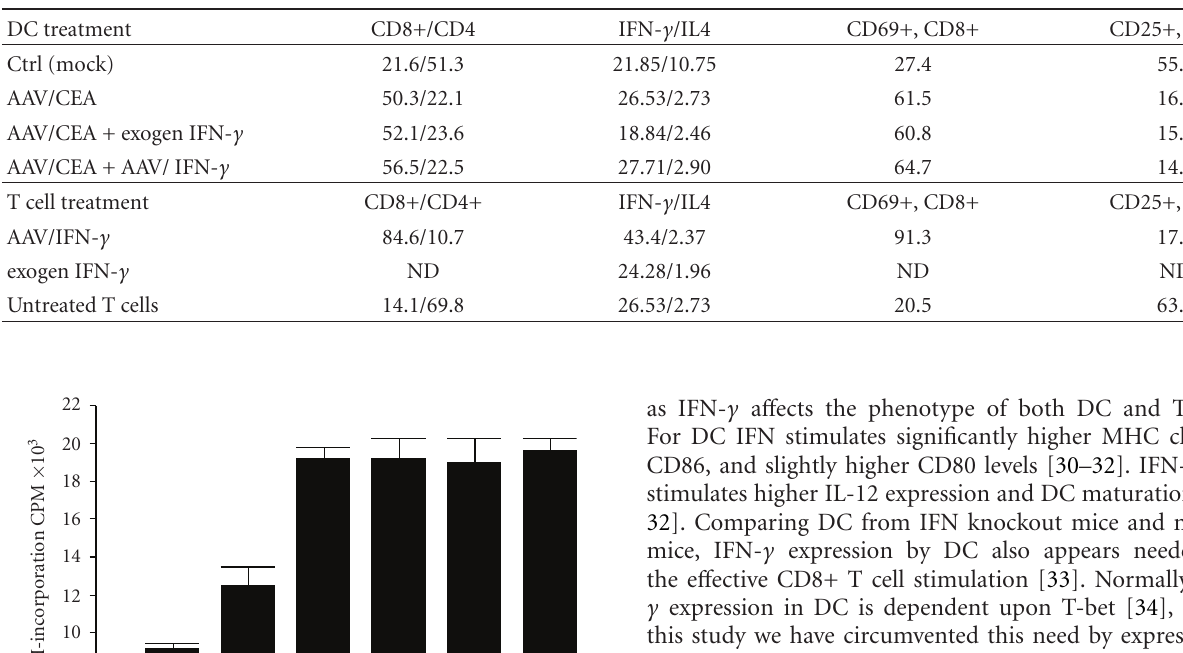
Table 2: Characterization T cell subsets and cytokine expression as percentages, from AAV-infected DC (top panel) and rAAV-infected T cells (bottom panel).